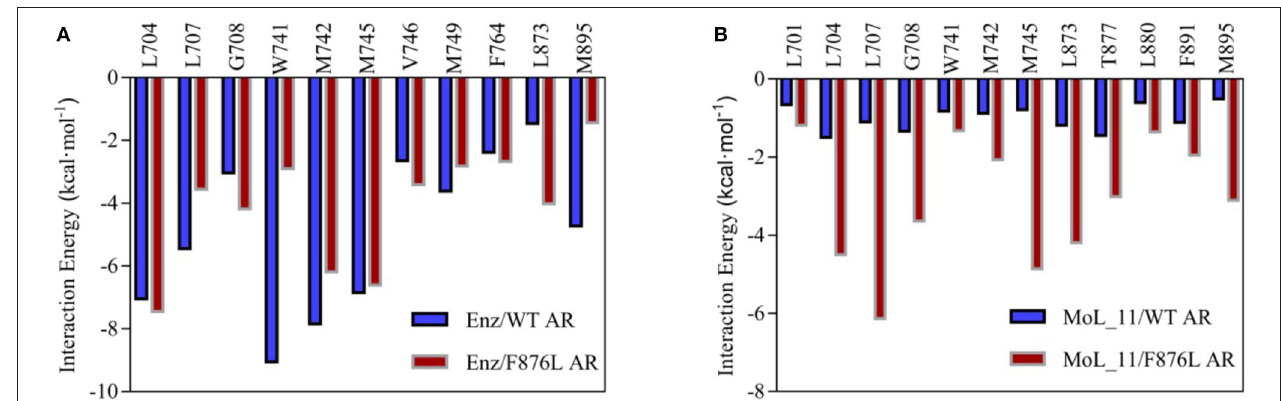
FIGURE 7 | Residue energy decomposition diagram. (A) is the energy decomposition diagram of enzalutamide and wild-type and mutant AR residues, and (B) is the energy decomposition diagram of MoL_11 and wild-type and mutant AR residues (unit: kcal • mol − 1